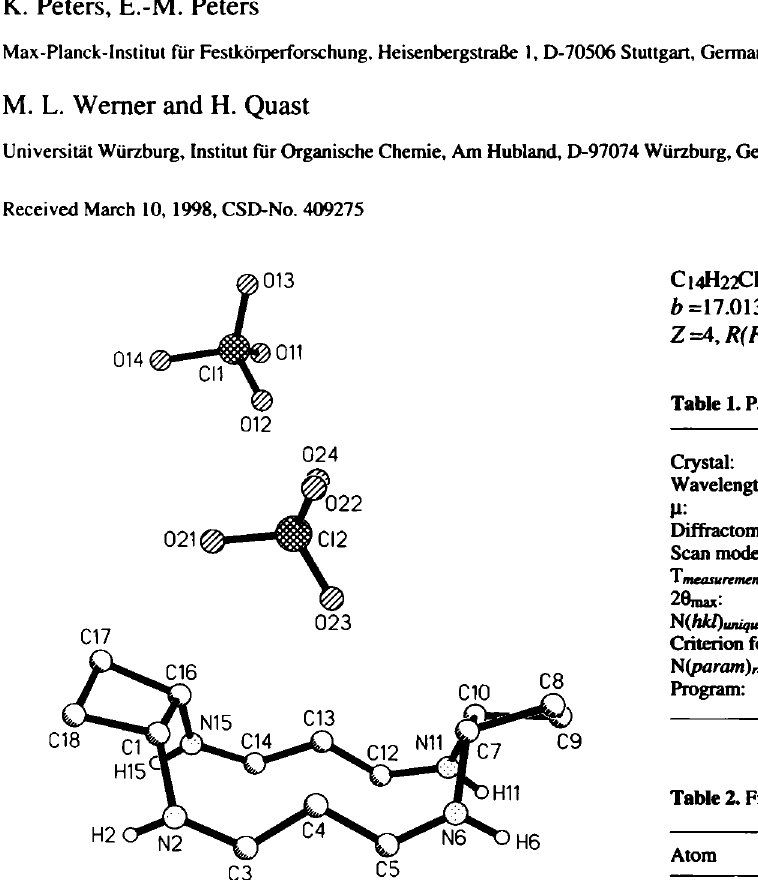
Table 2. Final atomic coordinates and displacement parameters (in